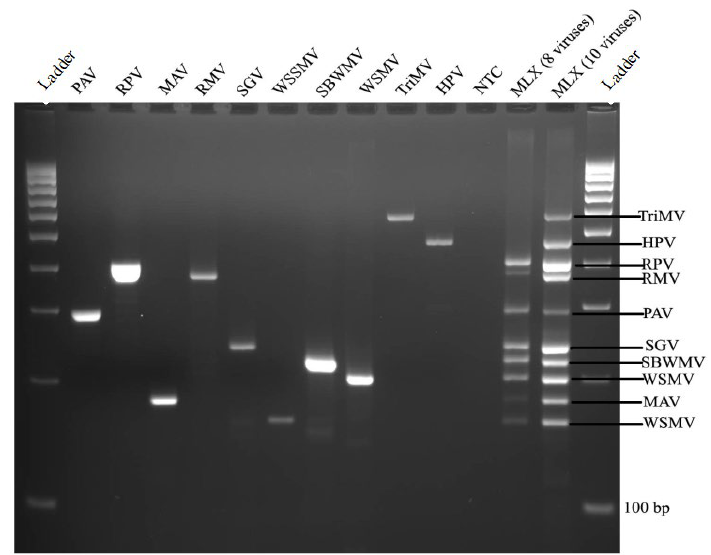
Figure 1. Multiplex RT-PCR with 10 wheat viruses. Lanes 2–11 show individual PCRs amplifying the two newly added viruses TriMV (Lane 10) and HPV (Lane 11) in addition to the YDV strains PAV, RPV, MAV, RMV, SGV (Lanes 2–6) and other wheat viruses WSSMV, SBWMV, and WSMV (Lanes 7–9) with a no template control (Lane 12). The M-RT-PCR identifying all these ten viruses in a multiplex (Lane 14) shows these added viruses as two new gel bands on the top in comparison to the previously developed multiplex PCR with eight viruses (Lane 13). Lanes 1 and 14 have 100 bp molecular marker as a reference.